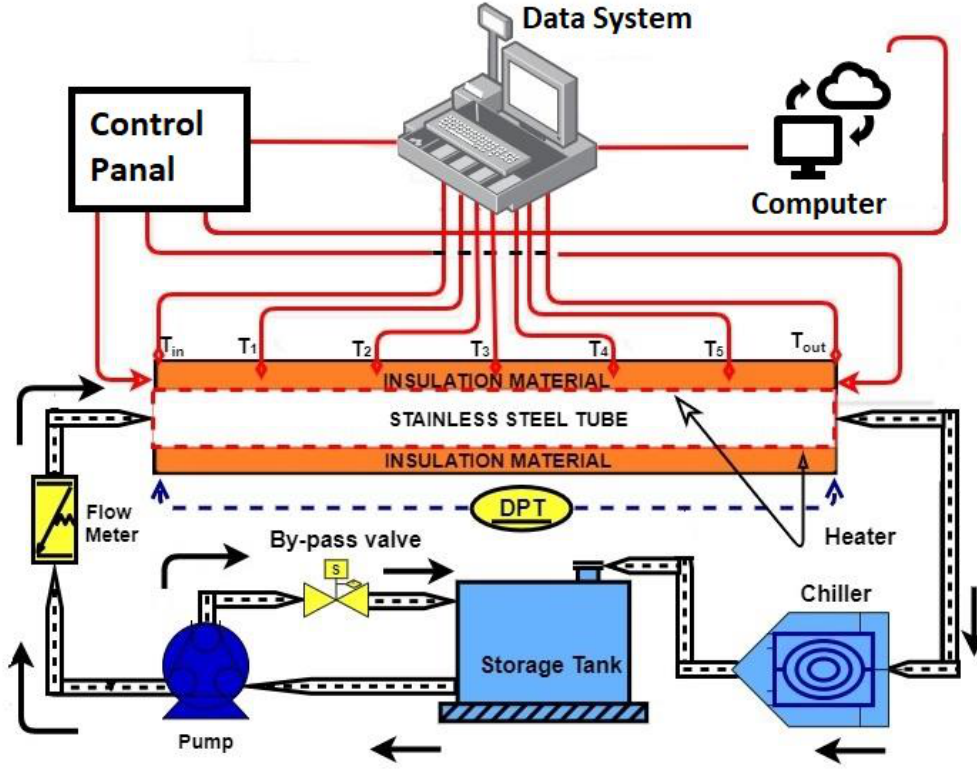
Figure 2. Diagram of the adopted experimental set-up.